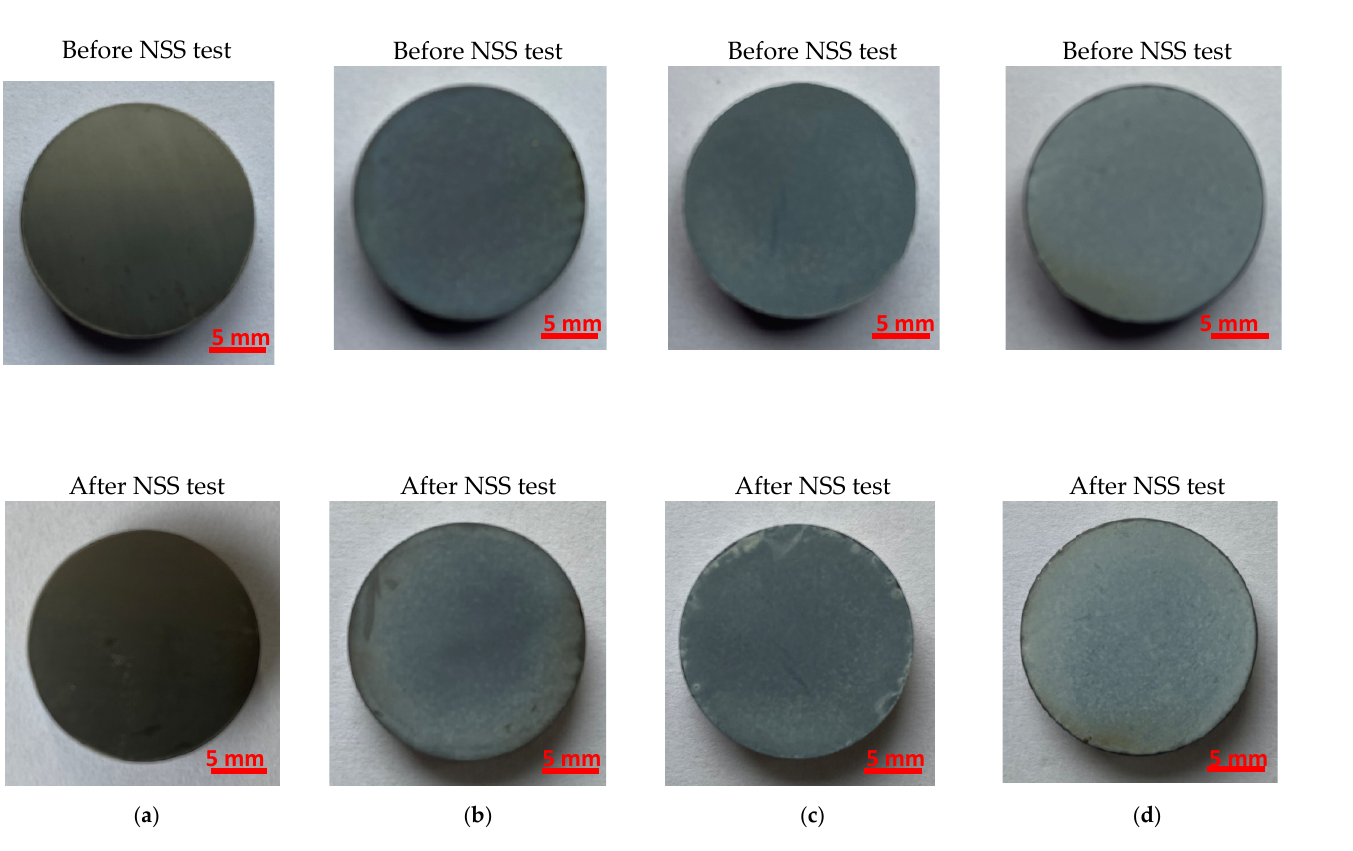
Figure 13. The Ti-13Zr-13Nb alloy surface before and after NSS test according to ISO 9227:2017 [44]: ( a ) Non-anodized substrate; ( b ) After anodizing at 15 V for 120 min; ( c ) After anodizing at 25 V for 120 min; ( d ) After anodizing at 35 V for 120 min.